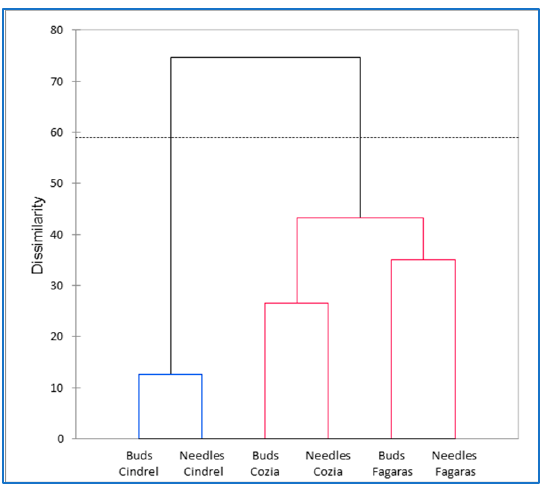
Figure 3. Distribution of the clusters for bud and needle samples from Cindrel-Iujbea, F ă g ă ra ș -Vi ş tea, Cozia-Rotunda.